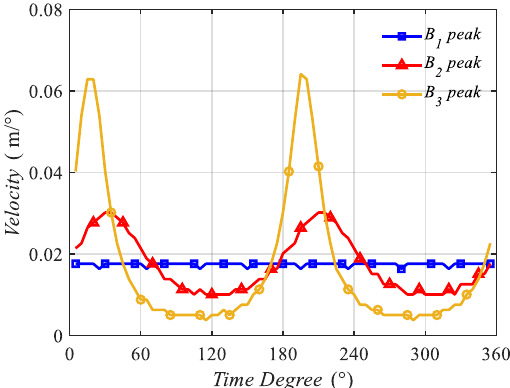
Figure 12. Z positions of the peak points of B 1 ( z , t ) , B 2 ( z , t ) , and B 3 ( z , t ) varying with the time degrees.